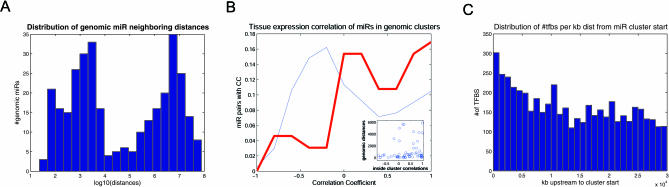
Analysis of miR Clusters in the Human Genome(A) Distribution of distances between all neighboring pre-miR genes in the human genome.(B) Distribution of tissue expression correlations between pairs of miRs: all possible pairs in the data (thin blue line) and pairs of miRs which reside in shared clusters (thick red line). In the inset are shown tissue expression correlations between pairs of miRs in the same genomic clusters versus distances between them.(C) Distribution of number of conserved TFBS 30 kb upstream of the 5′ most nucleotide in each miR clusters. Conserved TFBSs were taken from UCSC hg17.